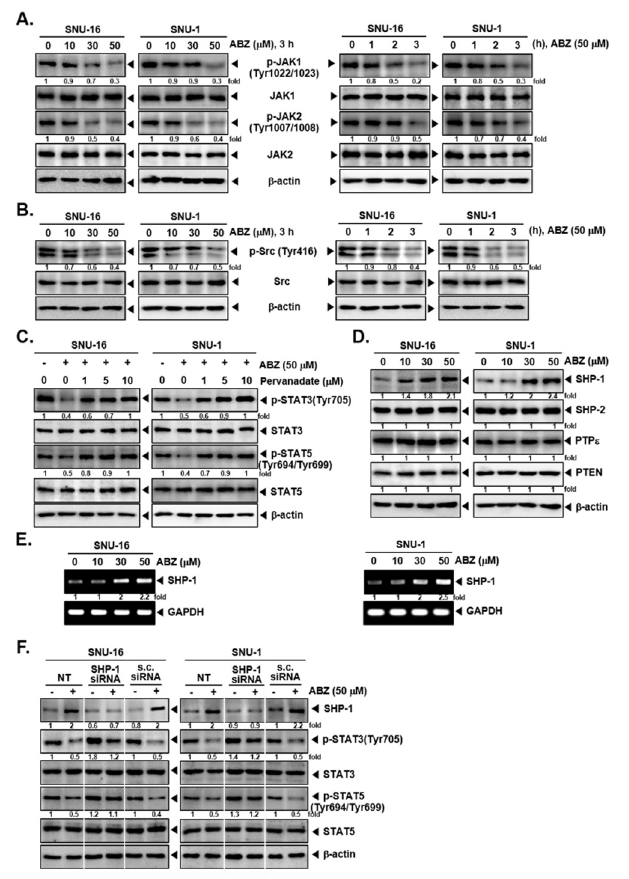
Figure 3. ABZ promotes protein SHP-1 levels in gastric carcinoma cells. ( A , B ) SNU-16 and SNU-1 cells were treated with (0, 10, 30, 50 µM ABZ) in a time dependent fashion (0, 1, 2, 3 h) and western blotting was performed. ( C ) The cells were pre-treated with various concentrations of pervanadate for 30 min, then incubated with 50 µM of ABZ for 3 h and western blotting was performed. ( D ) Cells were treated with 50 µM for 3 h, and western blot analysis was done. ( E ) RNA levels of SHP-1 was evaluated by RT-PCR. ( F ) Cells were transfected with scrambled or SHP-1 specific siRNA (100 nM). After 24 h, cells were treated with ABZ 50 µ M for 3 h and the western blotting was done. The results shown are representative of independent